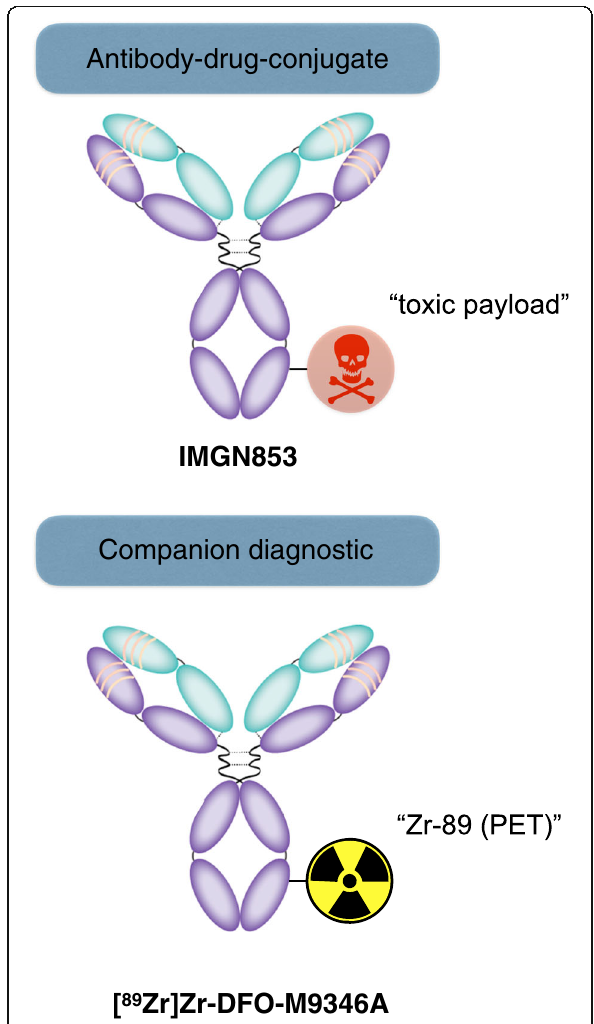
Fig. 1 Concept of an antibody-based companion diagnostic for cancer therapy using positron emission tomography (PET) imaging. The humanized antibody, M9346A, functions as targeting vector for antibody-drug-conjugate as well as companion